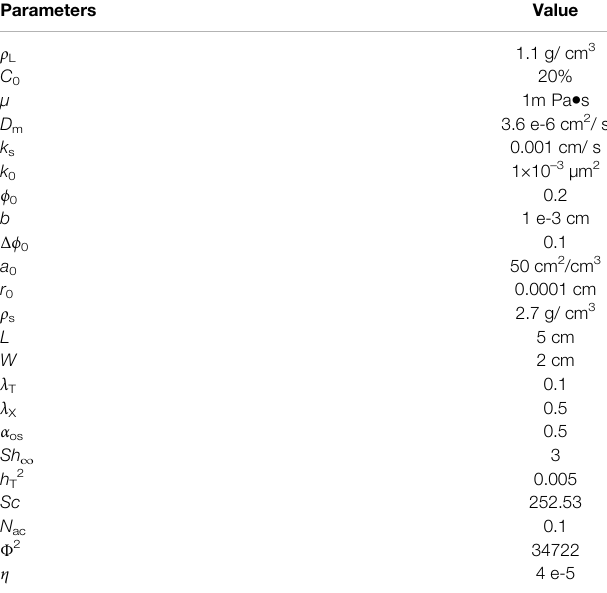
TABLE 1 | The parameters and values in numerical